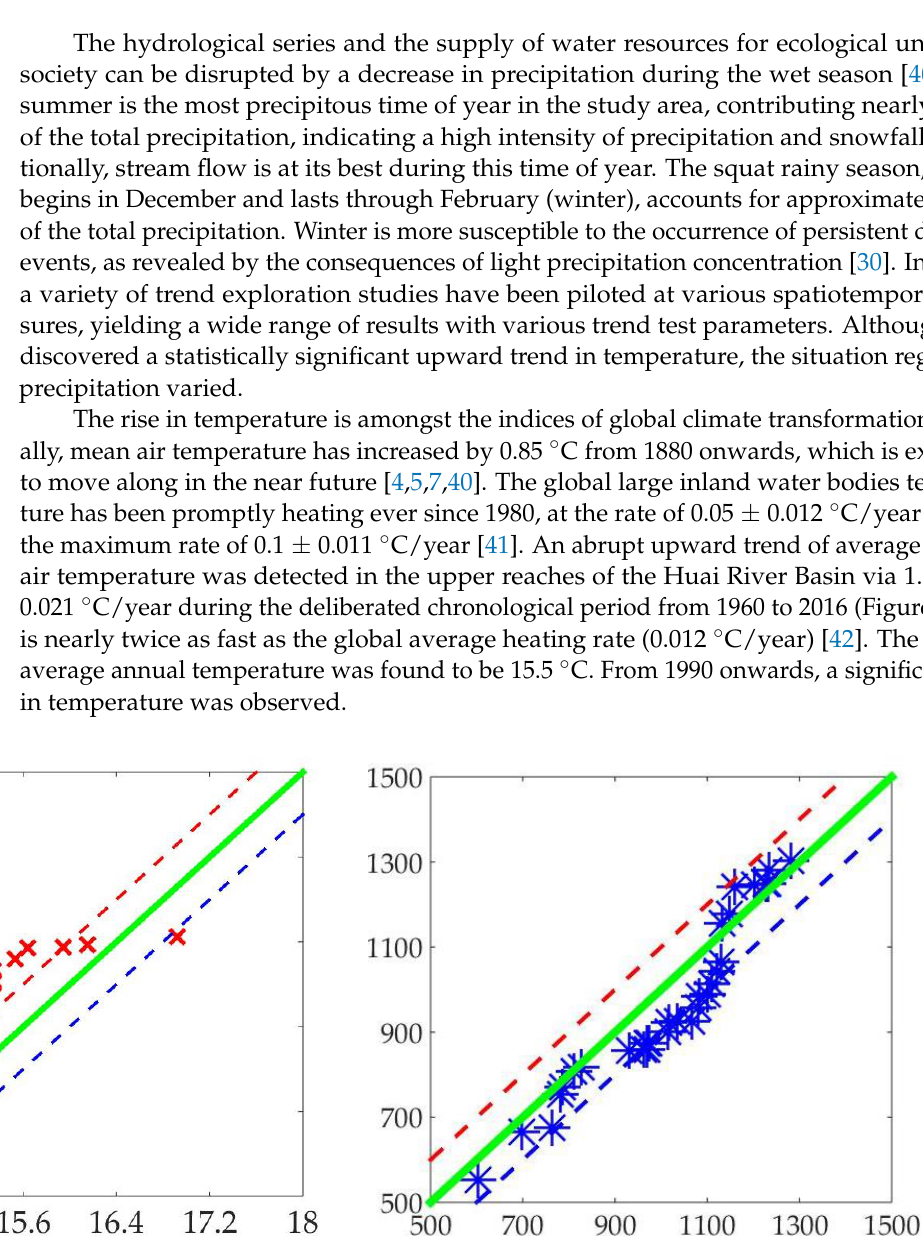
y = -0.6399x + 1015.4